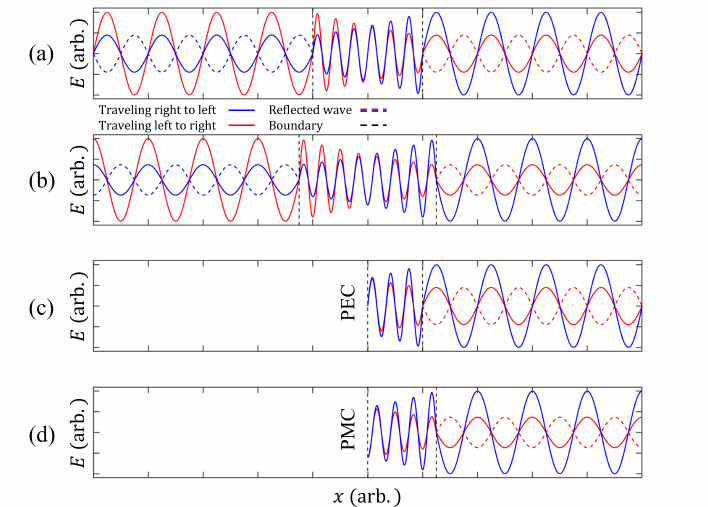
Figure 1. Model of simple CPA with ( a ) odd and ( b ) even symmetry of the resonance mode. The red (blue) curve show traveling waves to the left (right). Solid curves represent incident and transmitted waves; Dashed curves, reflected waves. The black dashed line is the boundary of the resonator. The resonance mode with even symmetry has two incident light rays that are in phase, and the mode with odd symmetry has two incident waves with a phase difference of ( 2 n + 1 ) π ( n = 0,1,2,...). Single-port resonator with ( c ) PEC and ( d ) PMC boundary. The size of the system with even (odd) symmetric mode can be reduced by using the PEC (PMC)